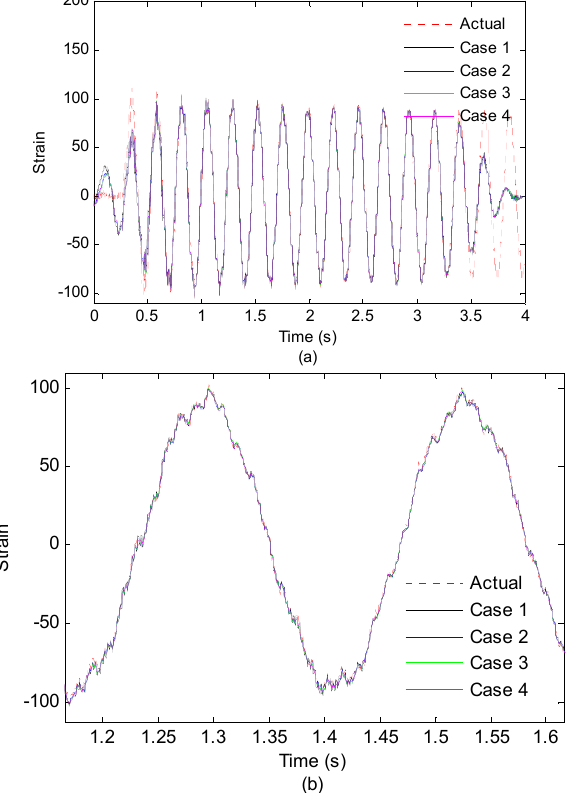
Figure 18. ( a ) Measured strain responses and reconstructed strain responses (using 1,2,3,14 measurement points) of the 5-th optical fiber measurement point on first 4 s; ( b ) Results are concentrated on 1.2–1.6 s for clear presentation. Table 5. Experimental results for 4 cases of the sensor number example.